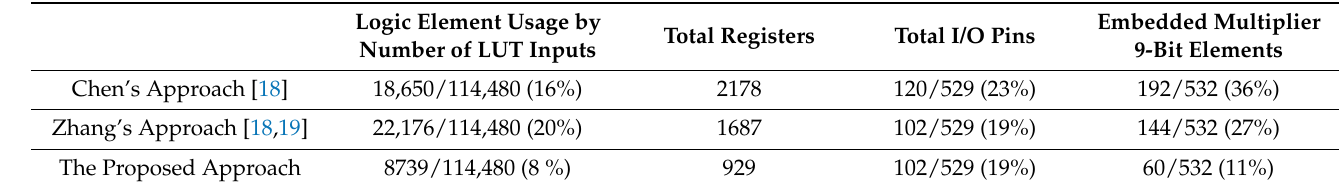
Table 4. Comparison of Hardware Resource Utilization of Altera (Proposed Tracking Approach).